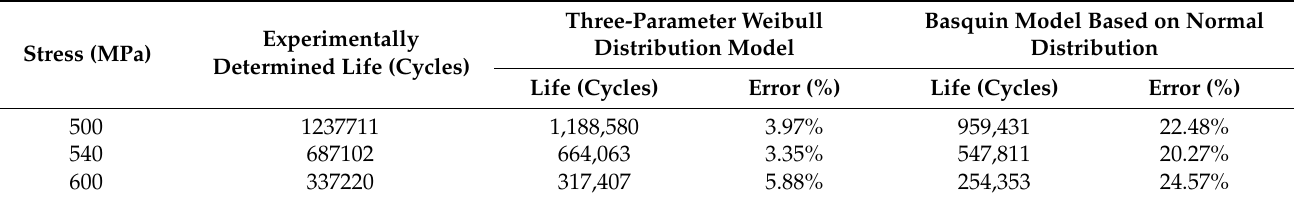
Table 5. Comparison of fatigue life of HY-type ultra-high strength sucker rod based on the three- parameter Weibull distribution model and the normal distribution Basquin